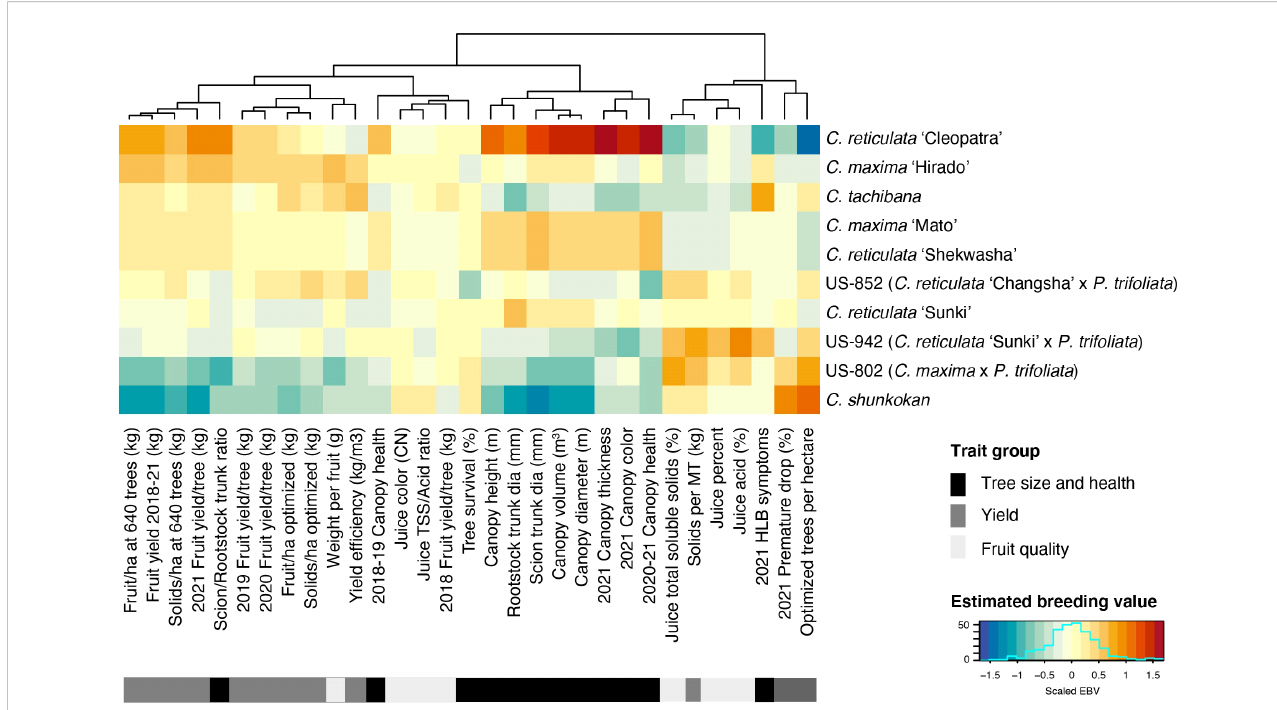
FIGURE 2 Estimated breeding value of parents. REML linear mixed models for each trait were used to predict the EBV of each parent. Each row represents a cultivar with the cultivar name listed on the y-axis. Cultivars were ordered from highest to lowest fruit yield (2018-2021). Trait names are shown on the x-axis and traits were grouped into three broad categories: tree size and health, yield, and fruit quality. The estimated breeding values for each trait/ cultivar combination are relative to the intercept of each model with positive values represented by warmer orange and red colors and negative values by cooler blue